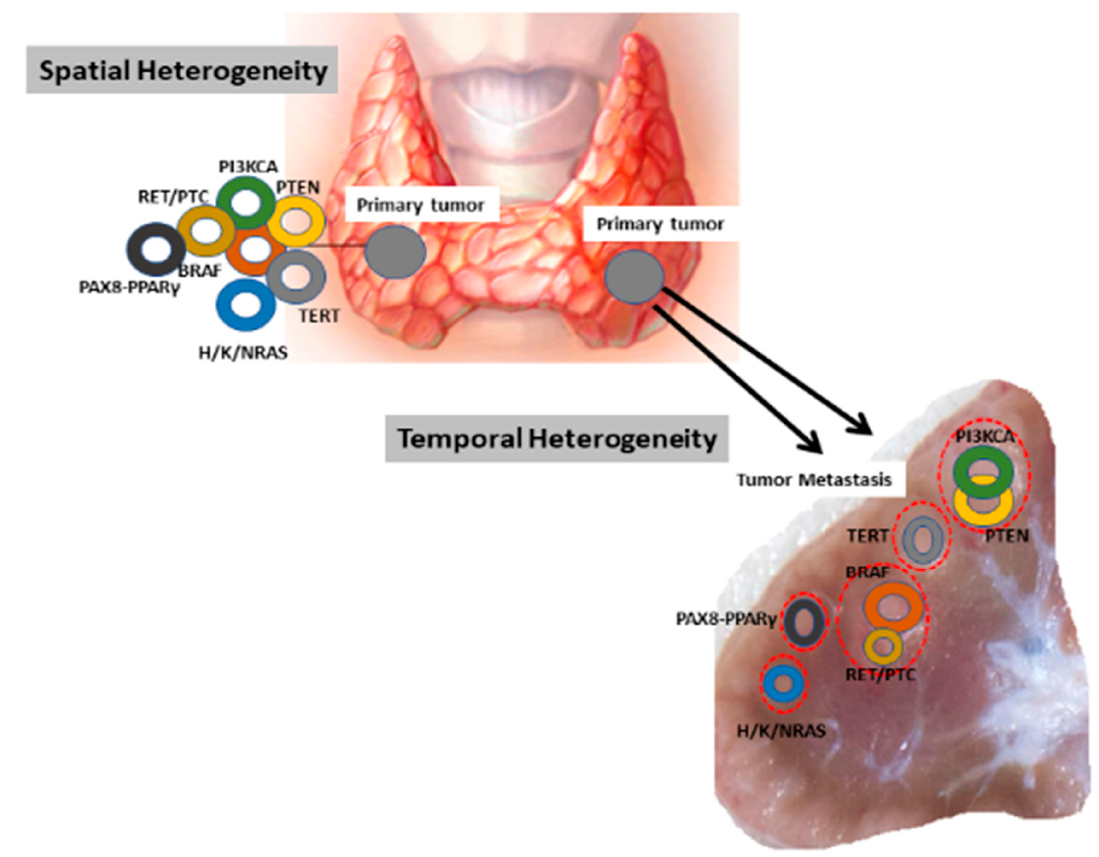
Figure 1. Spatio-temporal heterogeneity in primary and corresponding lymph node metastasis in thyroid tumors.